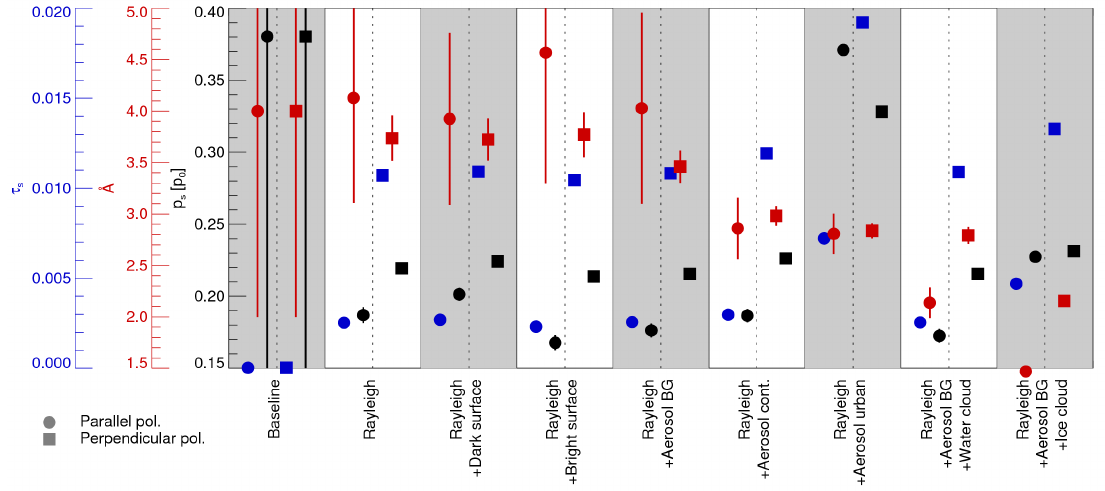
Figure 9. Retrieved scattering optical thickness, Ångström exponent, and height of the scattering layer for the 3-Scat setup and the scenarios ( θ 0 = 40°): baseline , Rayleigh , Rayleigh+Darksurface , Rayleigh+Brightsurface